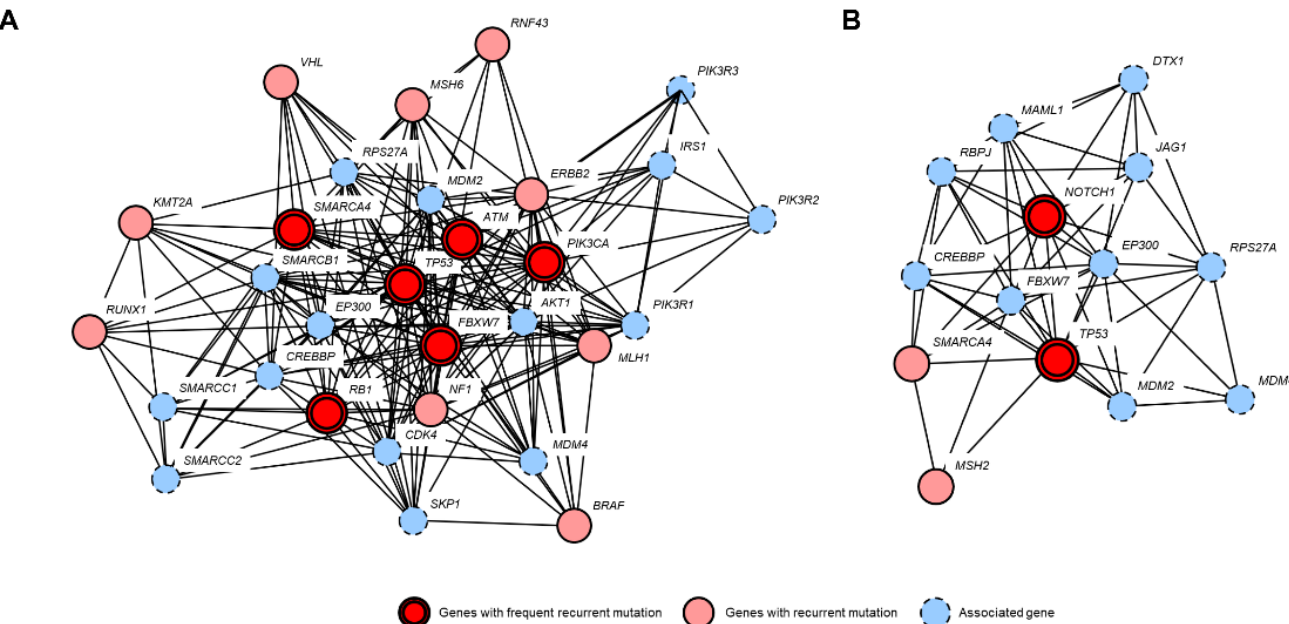
Figure 3. Analysis of PPI based on genes with recurrent mutation and associated genes. ( A ) Ocular sebaceous carcinoma (SeC-O). ( B ) Extraocular sebaceous carcinoma (SeC-EO). The TP3 pathway, SWItch/Sucrose Non-Fermentable (SWI/SNF) pathway, and MMR pathway were shared by both SeC-O and SeC-EO. The PI3K/AKT/mTOR pathway ( PIK3CA ) and Notch signaling pathway ( NOTCH1 ) were unique to SeC-O and Sec-EO, respectively. Table 3. List of genes with frequent pathogenic mutations according to the molecular